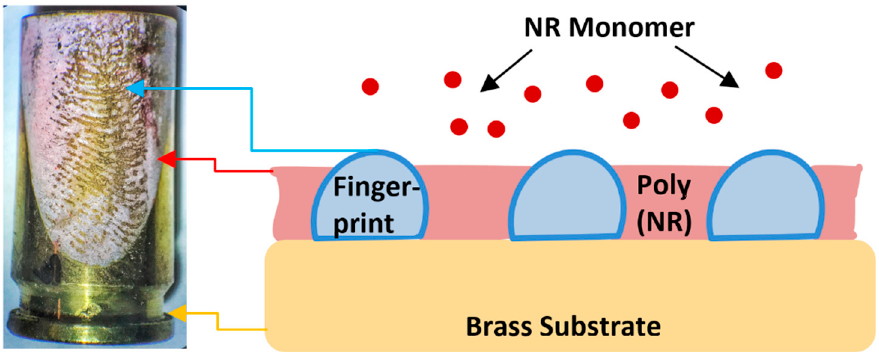
Figure 1. Scheme of visualization of fingerprint on brass cartridge using poly(neutral red) film.